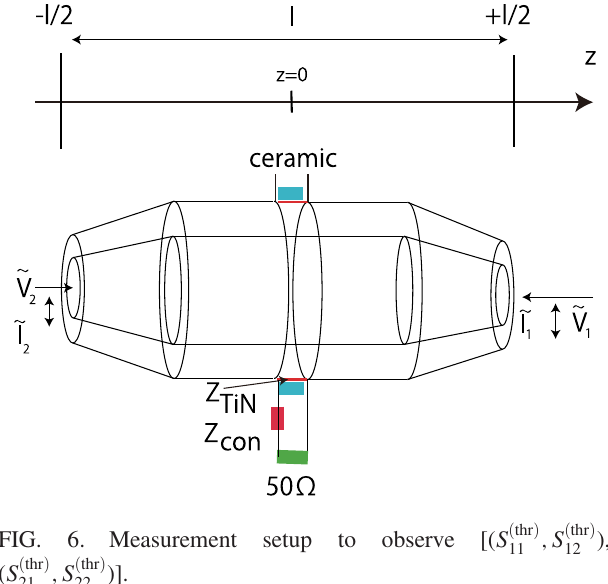
FIG. 6. Measurement setup to observe [( S ð thr Þ ð thr Þ ( S 21 ; S 22